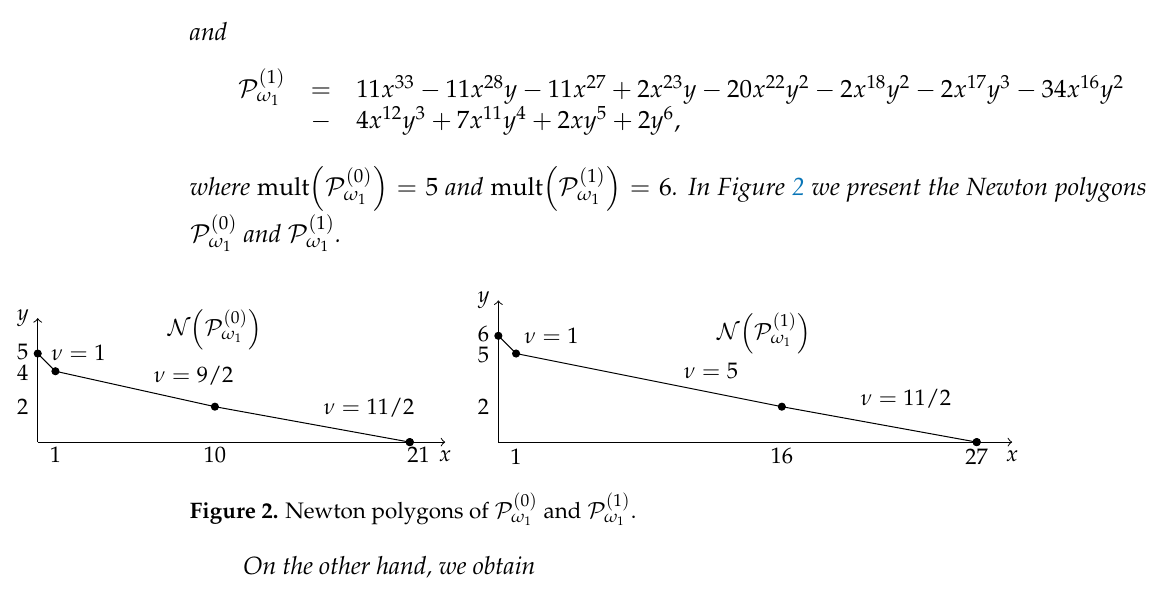
Figure 2. Newton polygons of P